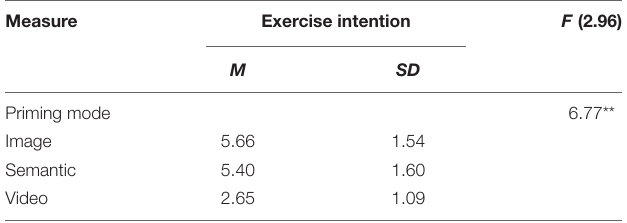
TABLE 2 | One-way ANOVA: the influence of mental simulation priming modes on intentions to exercise. Measure Exercise intention